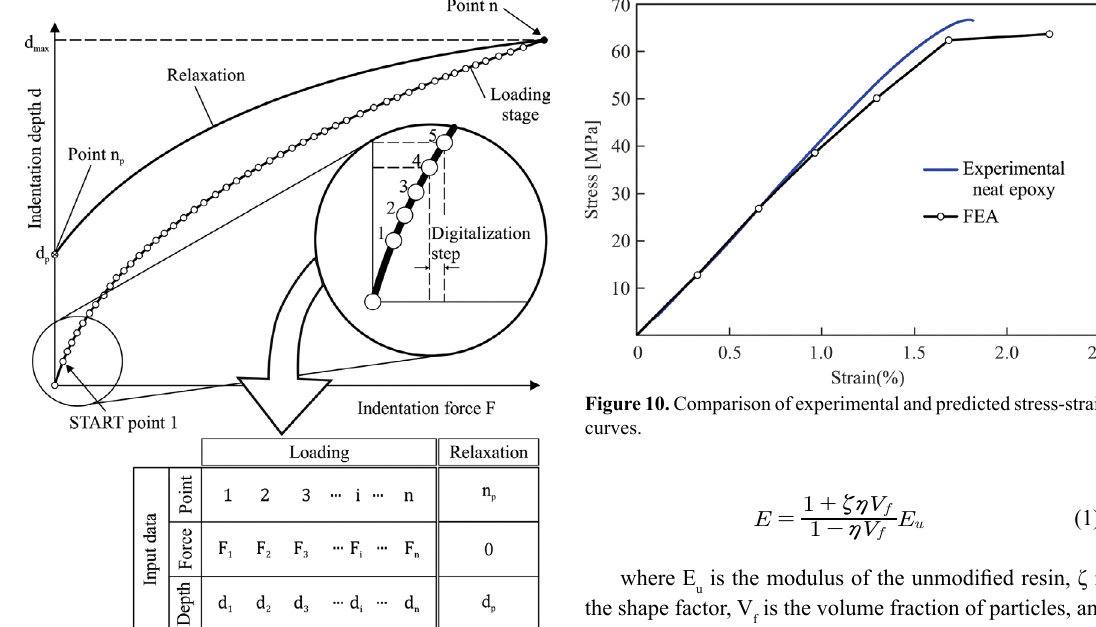
Figure 8. Digitalization of the nanoindentation results diagram to create the input data to the developed algorithm.